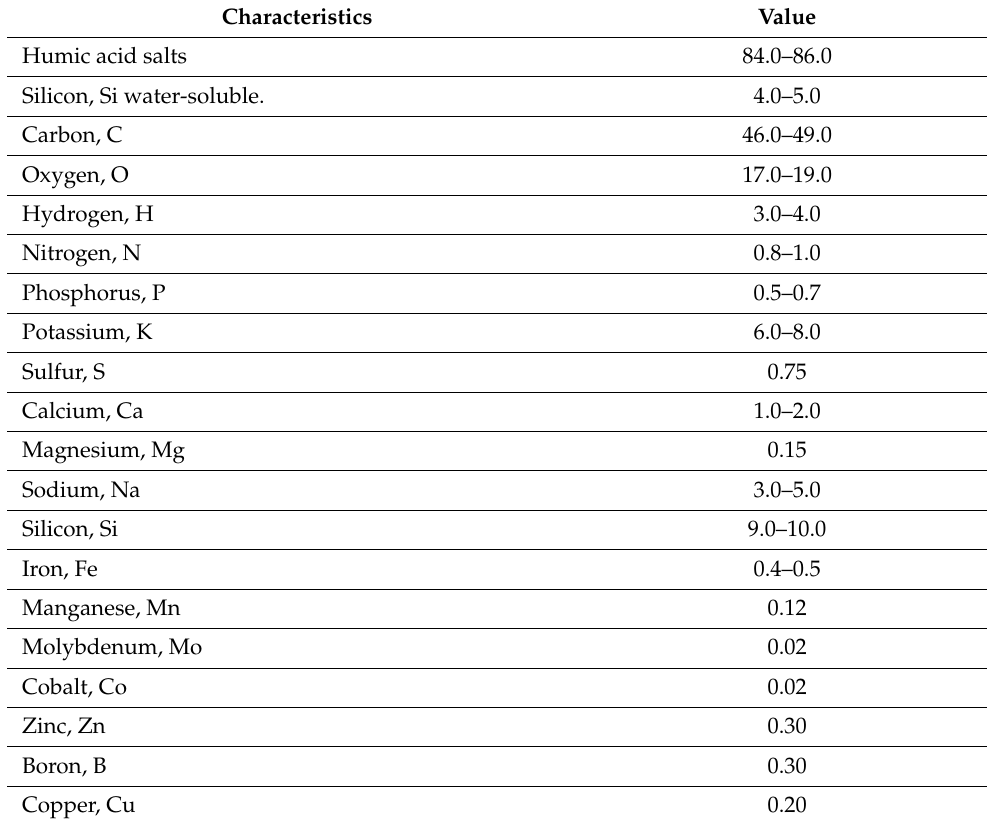
Table 2. Characteristics of sodium humate by the content of salts of humic acids and micro- and macroelements, % (V/V)